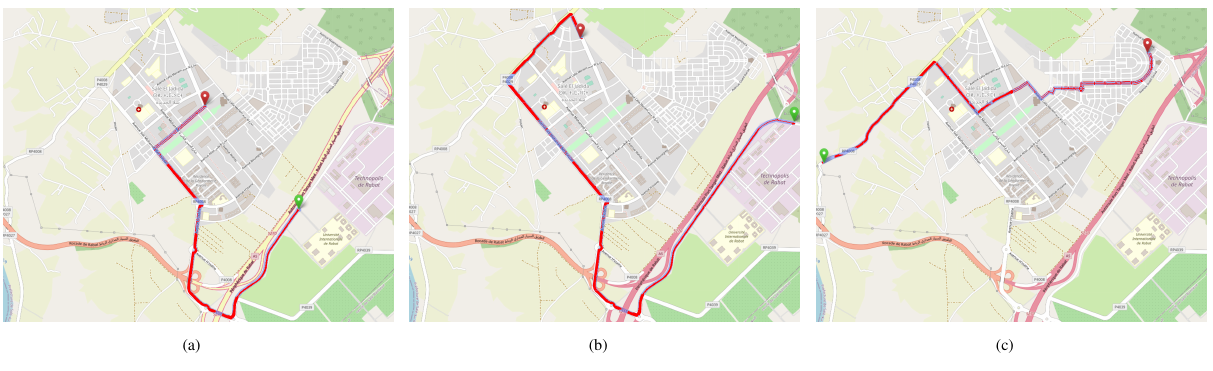
Fig. 2 Three itineraries used in the